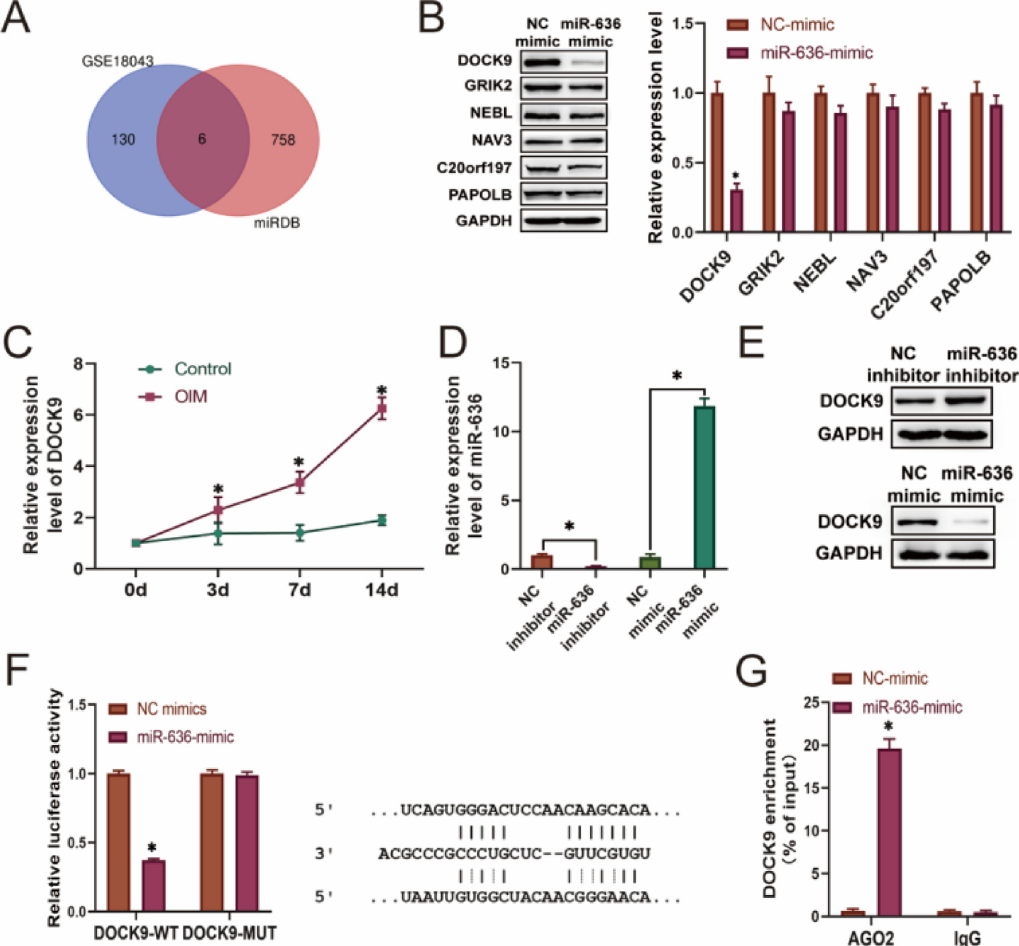
Fig. 4. miR-636 binds to the 3 ′ -UTR of DOCK9. The miRDB database and GSE18043 dataset were used to identify the target genes of miR-636 (A), and Western blot- ting and q-PCR were performed to detect the expression of intersected genes (B). q-PCR results showed the expression of DOCK9 in BM-MSCs (C). BM-MSCs with over- expression or reduced expression of miR-636 were constructed, and q-PCR (D) and Western blotting (E) were respectively utilized to examine the transfection ef fi cacy and DOCK9 expression. Dual Luciferase Reporter (F) and RIP (G) assays were applied to elaborate the relationship between miR-636 and DOCK9. * p < 0.05. Data repre- sent at least three independent sets of